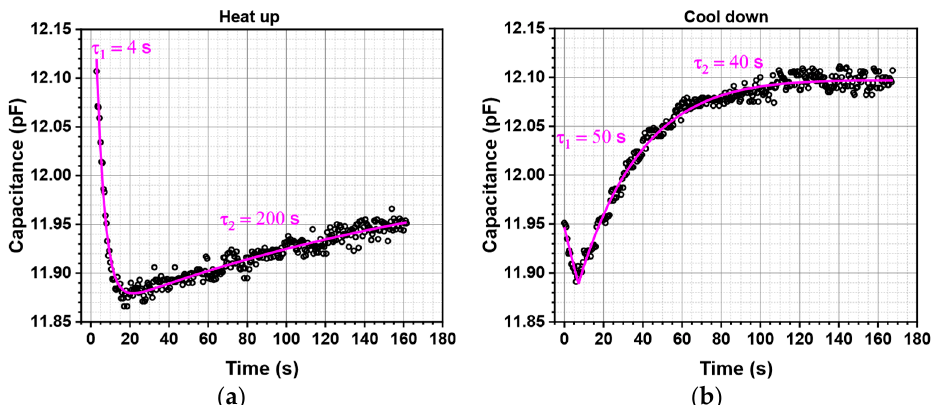
Figure 2. Diffusion characteristics of water vapor into a heated polyimide layer. The diffusion processes were fitted using Equation from the model of Li and Tanaka [4]: ( a ) after applying a thermal stress; ( b ) after turning off the thermal